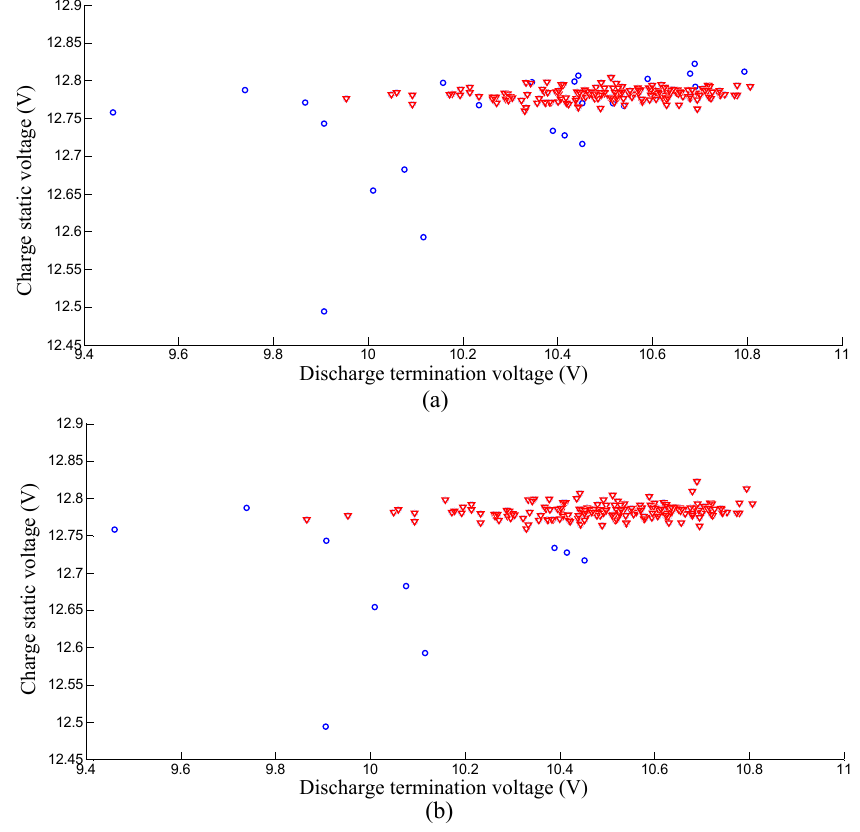
Figure 12. Comparison of failure amounts ( m = 5): ( a ) Results of original k-nearest-neighbor algorithm; ( b ) Results of the proposed method. Note that the red triangles represent the successfully-grouped batteries and the blue circles denote those grouping-failed (“orphan”)